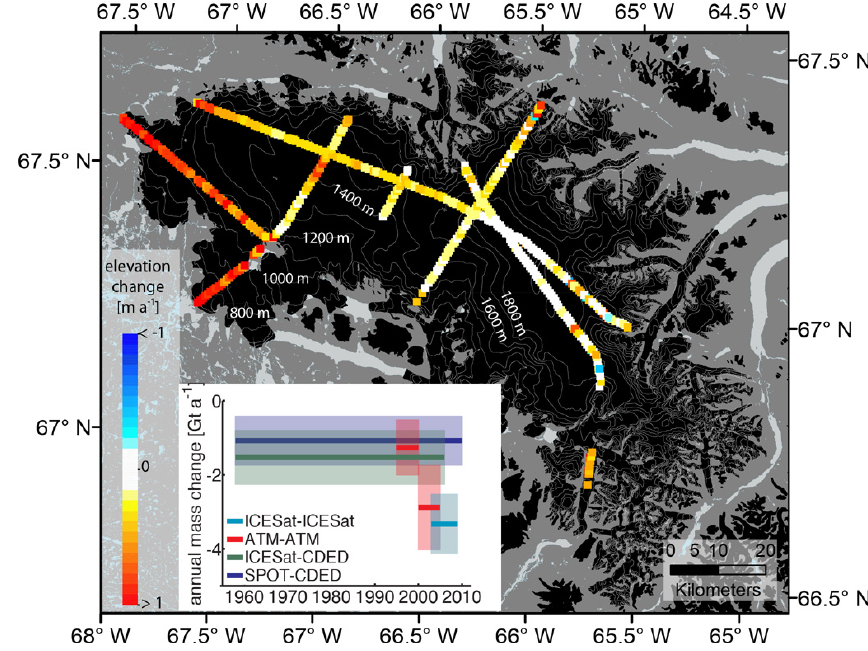
Fig. 7. Elevation change rate (ma − 1 ) of the Penny Ice Cap between spring 2000 and spring 2005 as determined from repeat airborne laser altimetry. Inset graph shows annual mass change of the Penny Ice Cap determined over varying time periods with corresponding 95% confidence intervals. A mass change of 1Gta − 1 =154kgm − 2 a − 1 .